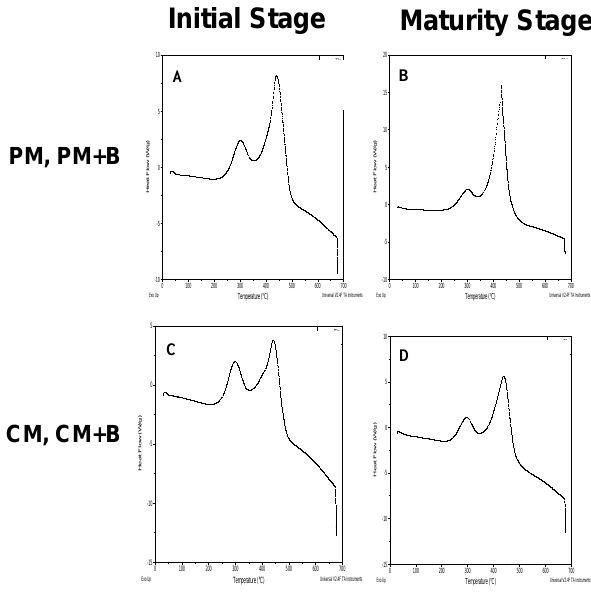
Figure 1. The TGS-DSC analysis of poultry manure PM, poultry manure + biochar (PM+B), cow manure (CM), cow manure + biochar (CM+B). Dotted lines exhibit the compost without biochar, while continuous lines exhibit the compost with biochar. (A) initial stage of PM+B and PM; (B) maturity stage of PM+B and PM; (C) initial stage of CM+B and PM; (D) maturity stage of CM+B and CM.